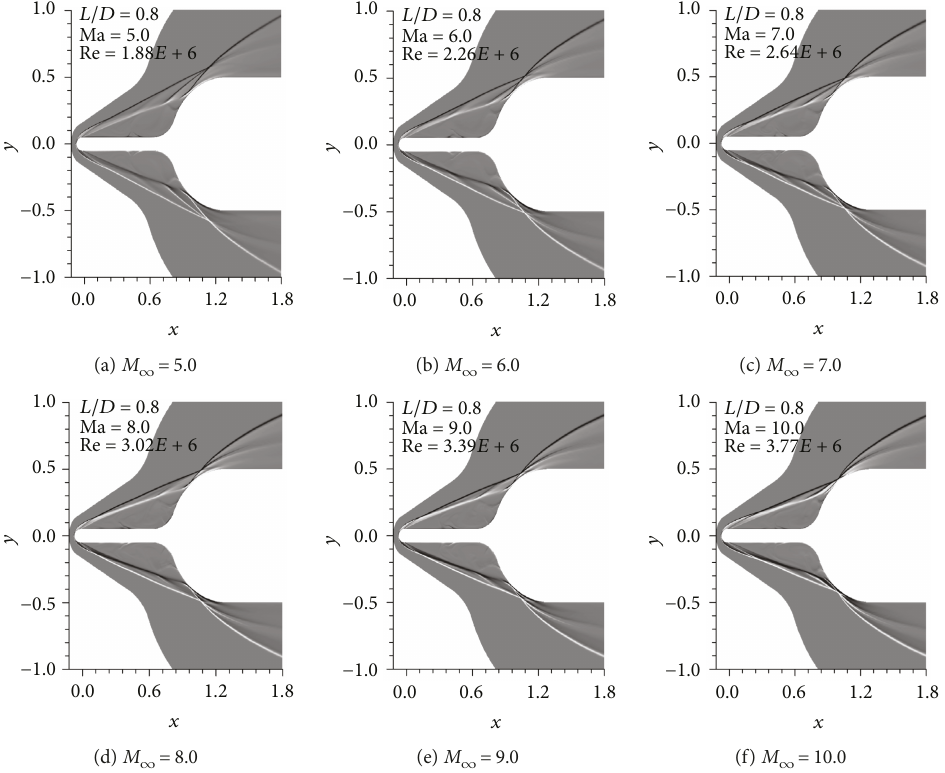
Figure 6: Flow fi eld density gradient in y direction of pure spiked blunt bodies. Spike length L/D =